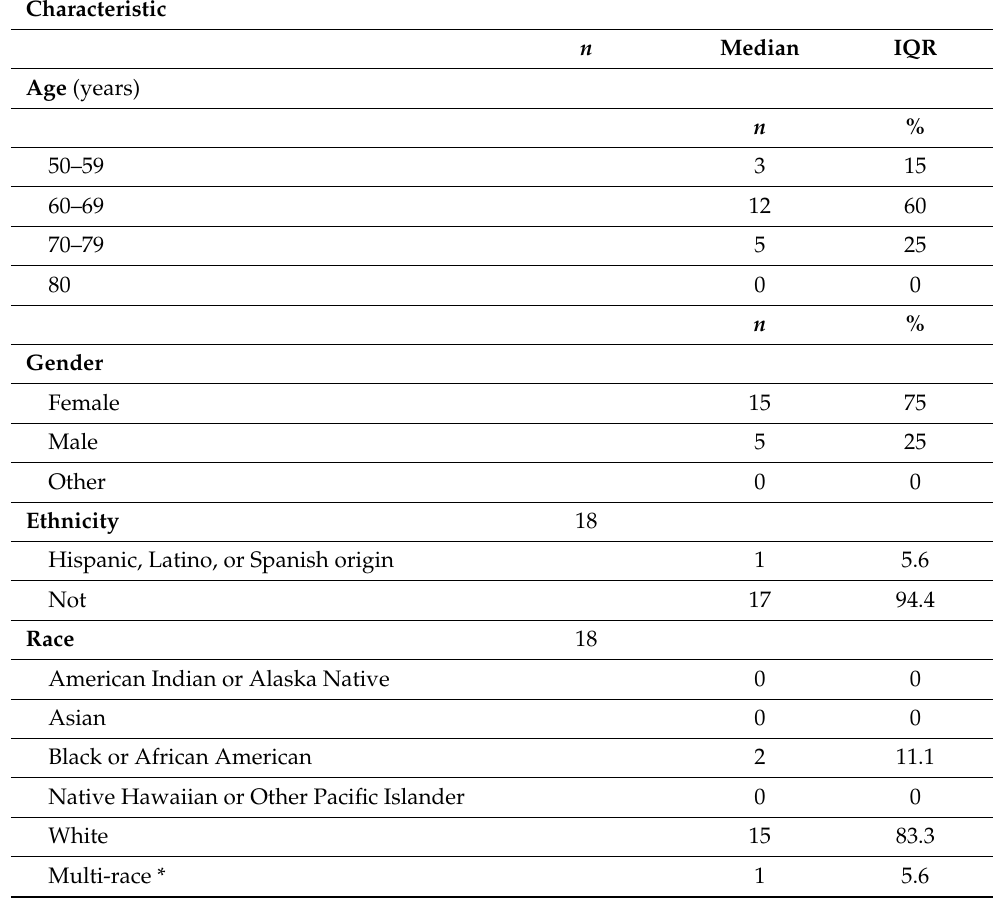
Table 1. Summaries of demographic characteristics ( n =